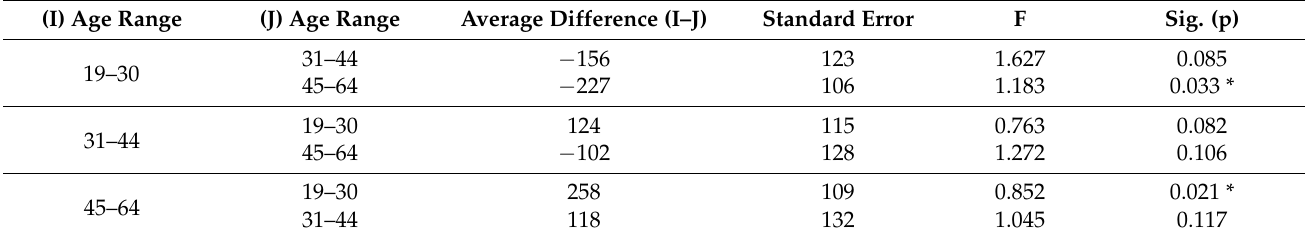
Table 10. Post-hoc analysis of the time spent on wayfinding tasks for three different age groups. (I) Age Range (J) Age